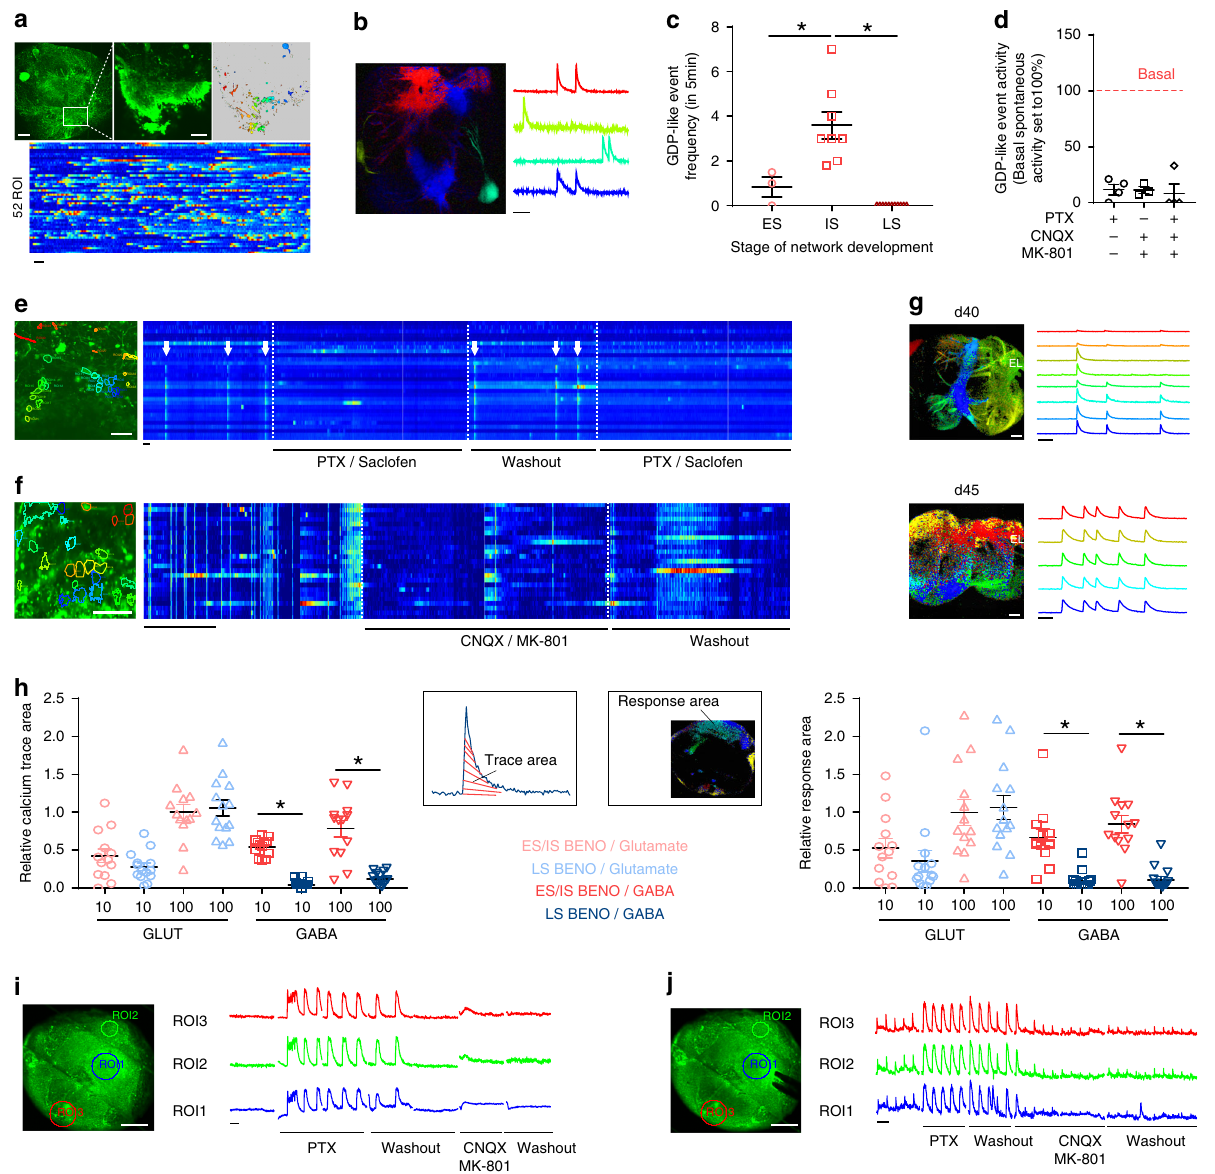
Fig. 4 Development of neuronal networks during BENO generation. a Calcium activity in d21 BENO. Upper-left: overview of the complete organoid loaded with the calcium indicator Fluo-8-AM. Upper-middle: close-up view of the boxed area. Upper-right: active correlation map of different regions of interest (ROI) showing calcium activity; each ROI is representative for a speci fi c neuronal activity. Bottom: heat map of calcium activity of 52 neurons as a function of time. b Active correlation map of d35 BENO and color-coded calcium traces ( Δ F / F 0) showing GDP-like events (refer also to Supplementary Videos). c GDP-like event frequency at early stage (ES, d <25), intermediate stage (IS, 25< d <40), late stage (LS, 40< d <65); n = 15 organoids, 2 independent experiments, * P values for ES vs IS and IS vs LS were 0.0035 and <0.0001, respectively, one-way ANOVA with Sidak ’ s multiple comparisons post hoc test. d GDP-like event inhibition by PTX, CNQX, and MK-801; n = 3-4 organoids/group, 2 independent experiments. e , f , close-up view showing synchronized calcium activity (indicated by arrows) of individual neurons in d36 BENOs. Heat maps of 20 – 30 ROIs showing desynchronization upon GABA receptor blockade by PTX/ Saclofen ( e ) and glutamate receptor blockade by CNQX/MK-801 ( f ); note that upon washout synchronicity was restored. g Overview of calcium activity propagation induced by single pulses (100 µ A) in the same fused BENOs on d40 (1mm signal propagation relative to stimulation electrode) and on d45 (2mm signal propagation relative to stimulation electrode). h In ES and IS BENOs, GDP-like events were evoked by 10 and 100 µ mol/L GABA or 10 and 100 µ mol/L glutamic acid (calcium signals recorded from 3 independent organoids; symbols indicate data from 15 ROIs). In LS BENOs GDP-like events were evoked by glutamate, but not GABA (calcium signals recorded from 3 organoids of 1 experiment; symbols indicate data from 15 ROIs). Bar graphs summarize calcium trace area (left) and signal strength in response area (right), indicating the extent of the neuronal activity in the investigated BENO. Values were normalized to 100 µ mol/L glutamate responses in ES/IS and LS organoids; For relative trace area the p values of 10 and 100 µ mol/L GABA ES vs LS were 0.002 and <0.0001, respectively. For relative response area the p values of 10 and 100 µ mol/L GABA ES vs LS were 0.027 and 0.0011, respectively; one-way ANOVA with Tukey ’ s multiple comparisons post hoc test. i Representative traces of spontaneous calcium activity under GABAergic and glutamatergic inhibition in LS BENOs (representative image from ROIs recorded in 3 BENOs). j Electrical stimulation-induced calcium activity under GABAergic and glutamatergic inhibition in LS BENOs (representative image from ROIs recorded in 1 of 3 BENOs, n = 3 organoids, 2 independent experiments). Spontaneous and induced activity was enhanced under GABA receptor blockade, while induced activity under glutamatergic inhibition was reduced. Upon washout the network balance was restored. Scale bars: Overview 200 µ m; high magni fi cation 50 µ m. All time scale bars on calcium traces are 30s. Data are presented as mean